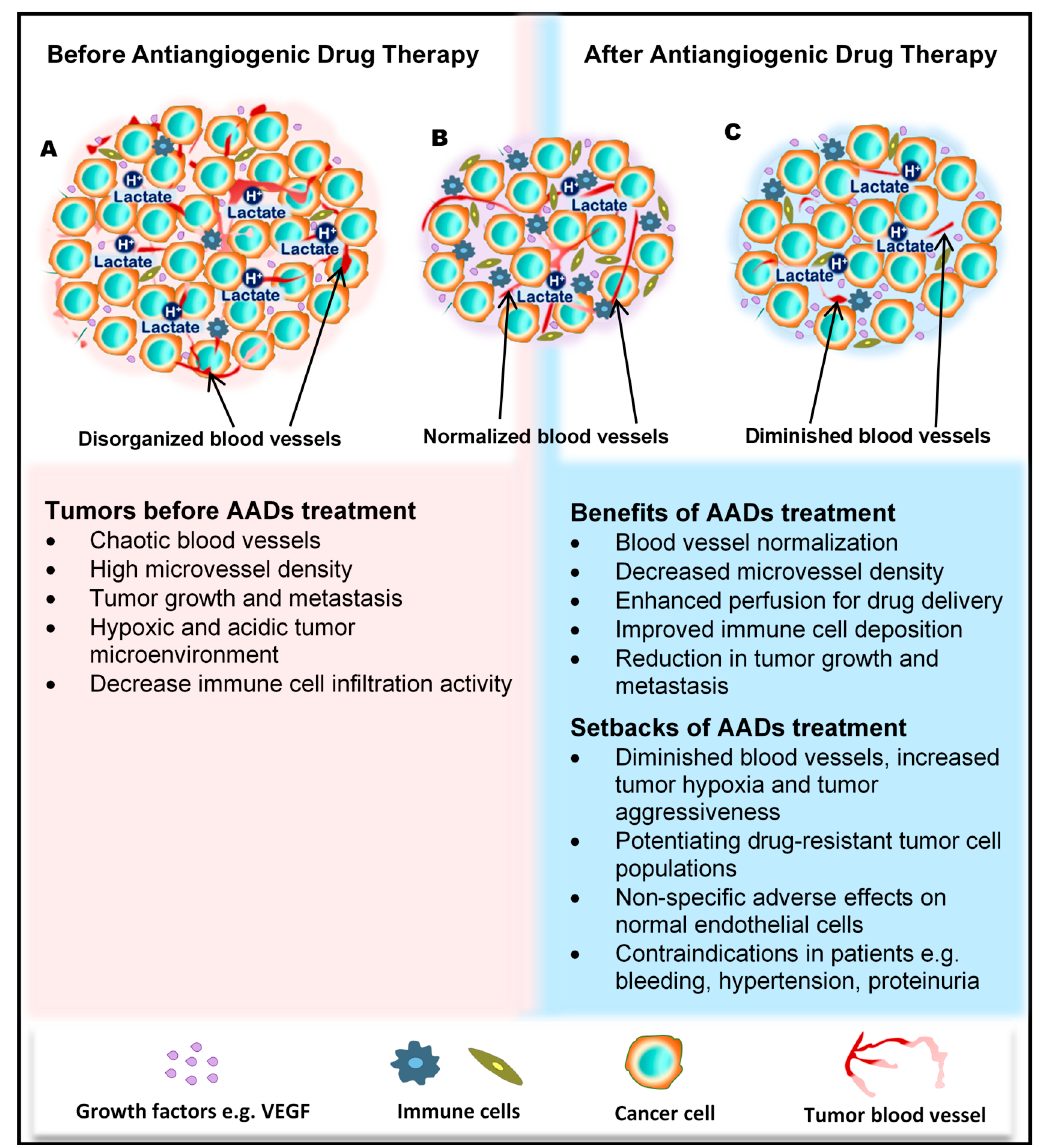
Figure 1. Benefits and side effects of antiangiogenic drugs. AADs, antiangiogenesis drugs. The dependency of tumors on their resident blood vessels to grow and metastasize has led to the targeting of tumor blood vessels to starve the tumor cells and close the metastasis portals. ( A ) Before the administration of AADs, the tumor histology is characterized by a high density of microvessels, with an undefined order of organization. The microenvironment is generally acidic, with high lactate levels, and immunologically suppressed. ( B ) However, after AAD therapy, tumor blood vessels become normalized, microvessel number reduces, tumor growth recedes, and immune cells infiltrate the tumors more through the normalized vasculature. ( C ) In addition to these benefits, AAD use causes some undesirable effects, including tumor hypoxia (from prolonged use of AADs) and destruction of normal vessels leading to bleeding. Patients may also experience hypertension and proteinuria, among others.